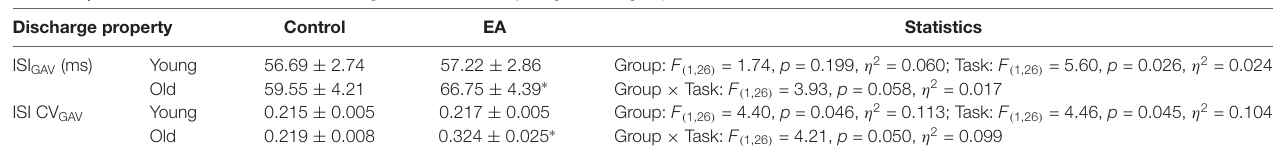
TABLE 3 | Mean and standard errors of discharge variables for the young and old groups in the control and EA conditions. Discharge